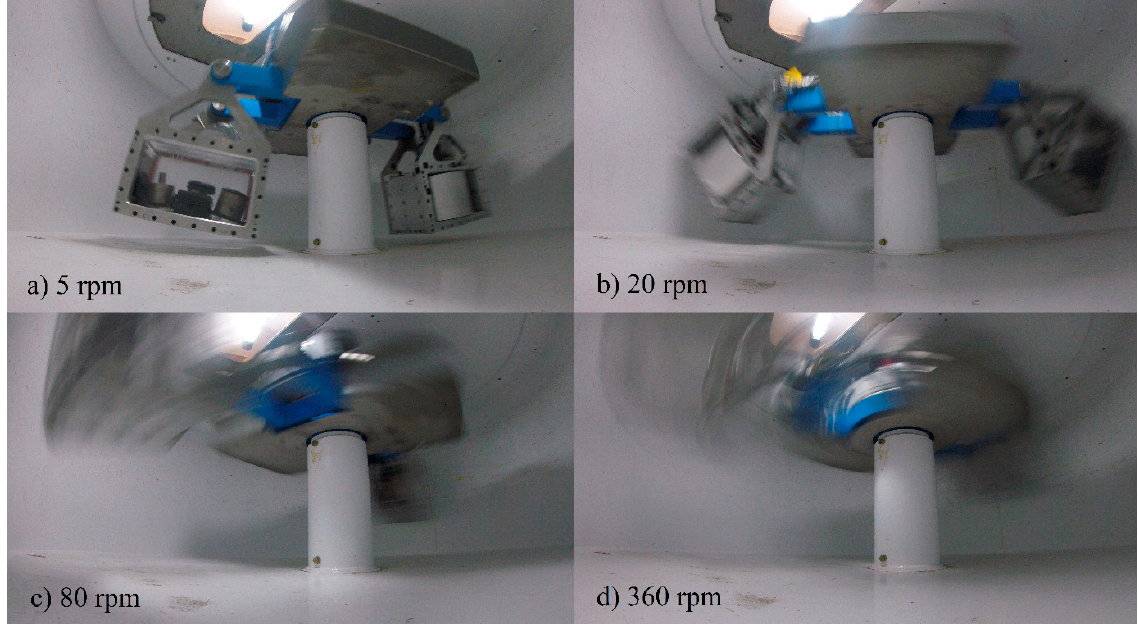
Figure 25. Model container installed on the beam centrifuge at the University of Manchester: ( a ) 5 rotations-per-minute; ( b ) 20 rotations-per-minute; ( c ) 80 rotations-per-minute; ( d ) 360 rotations-per-minute.